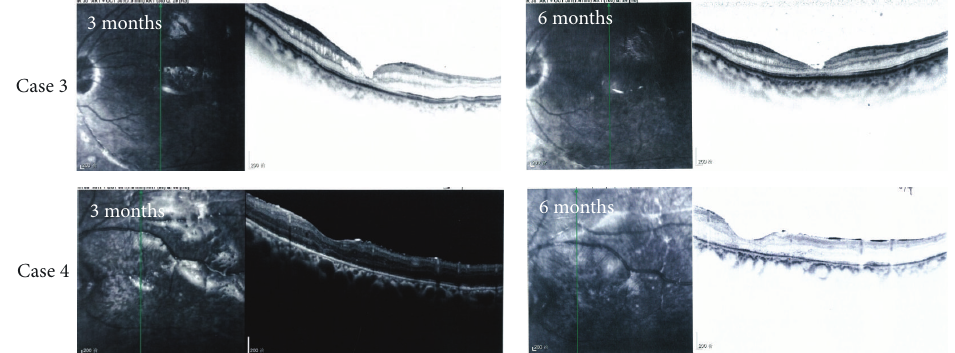
Figure 3: Attachment of the retina as demonstrated by OCT, at 3 and 6 months postoperatively. All the retinal reattachments were assessed relying on indirectly ophthalmoscopy. OCT images were supplied for additionally objective